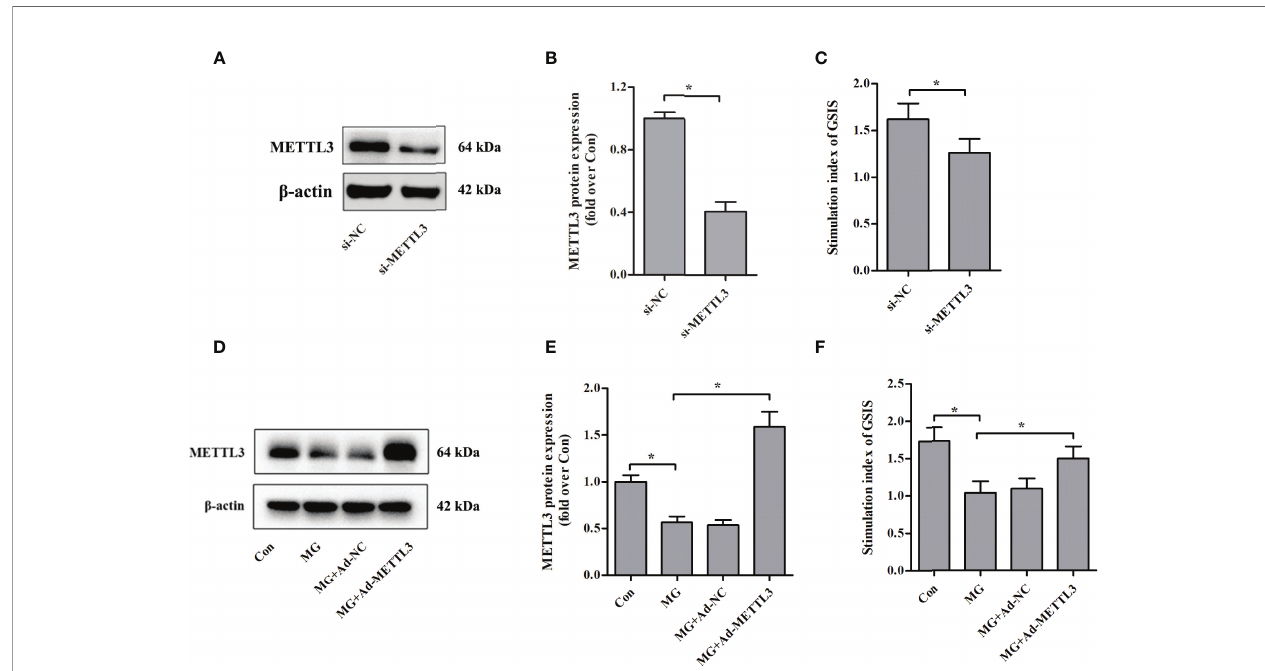
FIGURE 2 | Effects of METTL3 on GSIS from pancreatic b cells. (A, B) Immunoblot of METTL3 protein expression in NIT-1 cells transfected with METTL3 siRNA (si- METTL3) or a nonspeci fi c control siRNA (si-NC), which was set to 1. (C) The GSIS index of NIT-1 cells transfected with si-METTL3 or si-NC. (D, E) Immunoblot of METTL3 protein expression in NIT-1 cells (MG), NIT-1 cells transfected with METTL3 expression adenovirus (MG+Ad-METTL3), and NIT-1 cells transfected with a nonspeci fi c control adenovirus (MG+Ad-NC) that were treated with 1 mM of MG for 24 h. (F) The GSIS index in NIT-1 cells was transfected with Ad-METTL3 or Ad- NC and treated with 1 mM of MG for 24 h. Results are presented as the means ± SD of n = 3 – 4 independent experiments. * p <